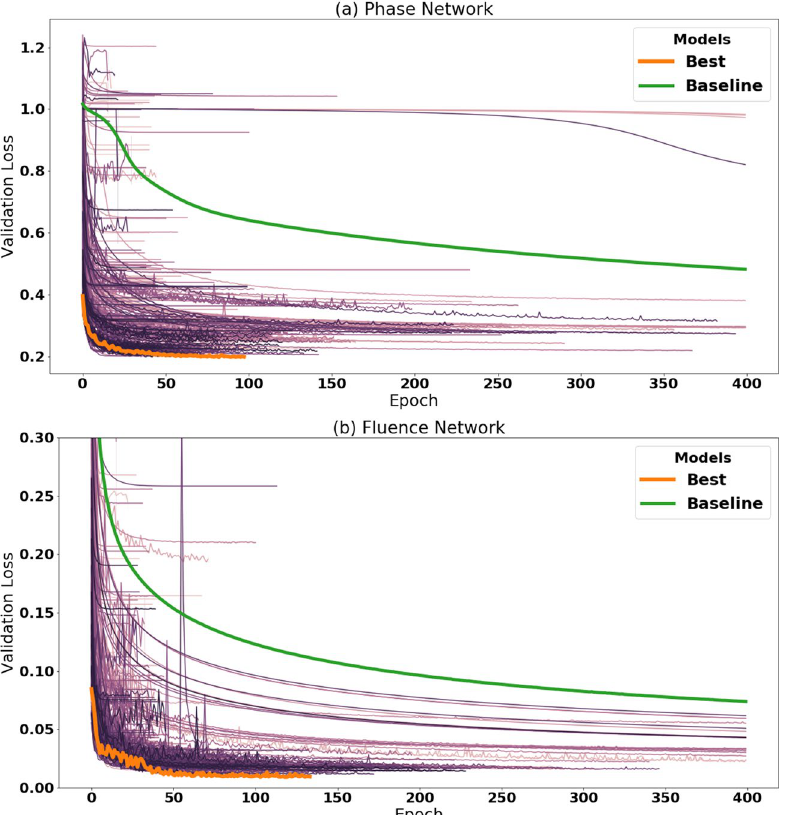
Figure 7. Validation loss of SHERPA trials, measured by the mean squared error, over time. Each line depicts the validation loss of a different SHERPA trial during the course of training of the simulated few-cycle networks. (a) Trials from phase networks with varying hyperparameters. (b) Trials from fluence networks with varying hyperparameters. Note: not all 500 trials are shown in each figure. Some trials with higher validation losses are left out for figure clarity. This discards 50 and 145 networks for a and b,